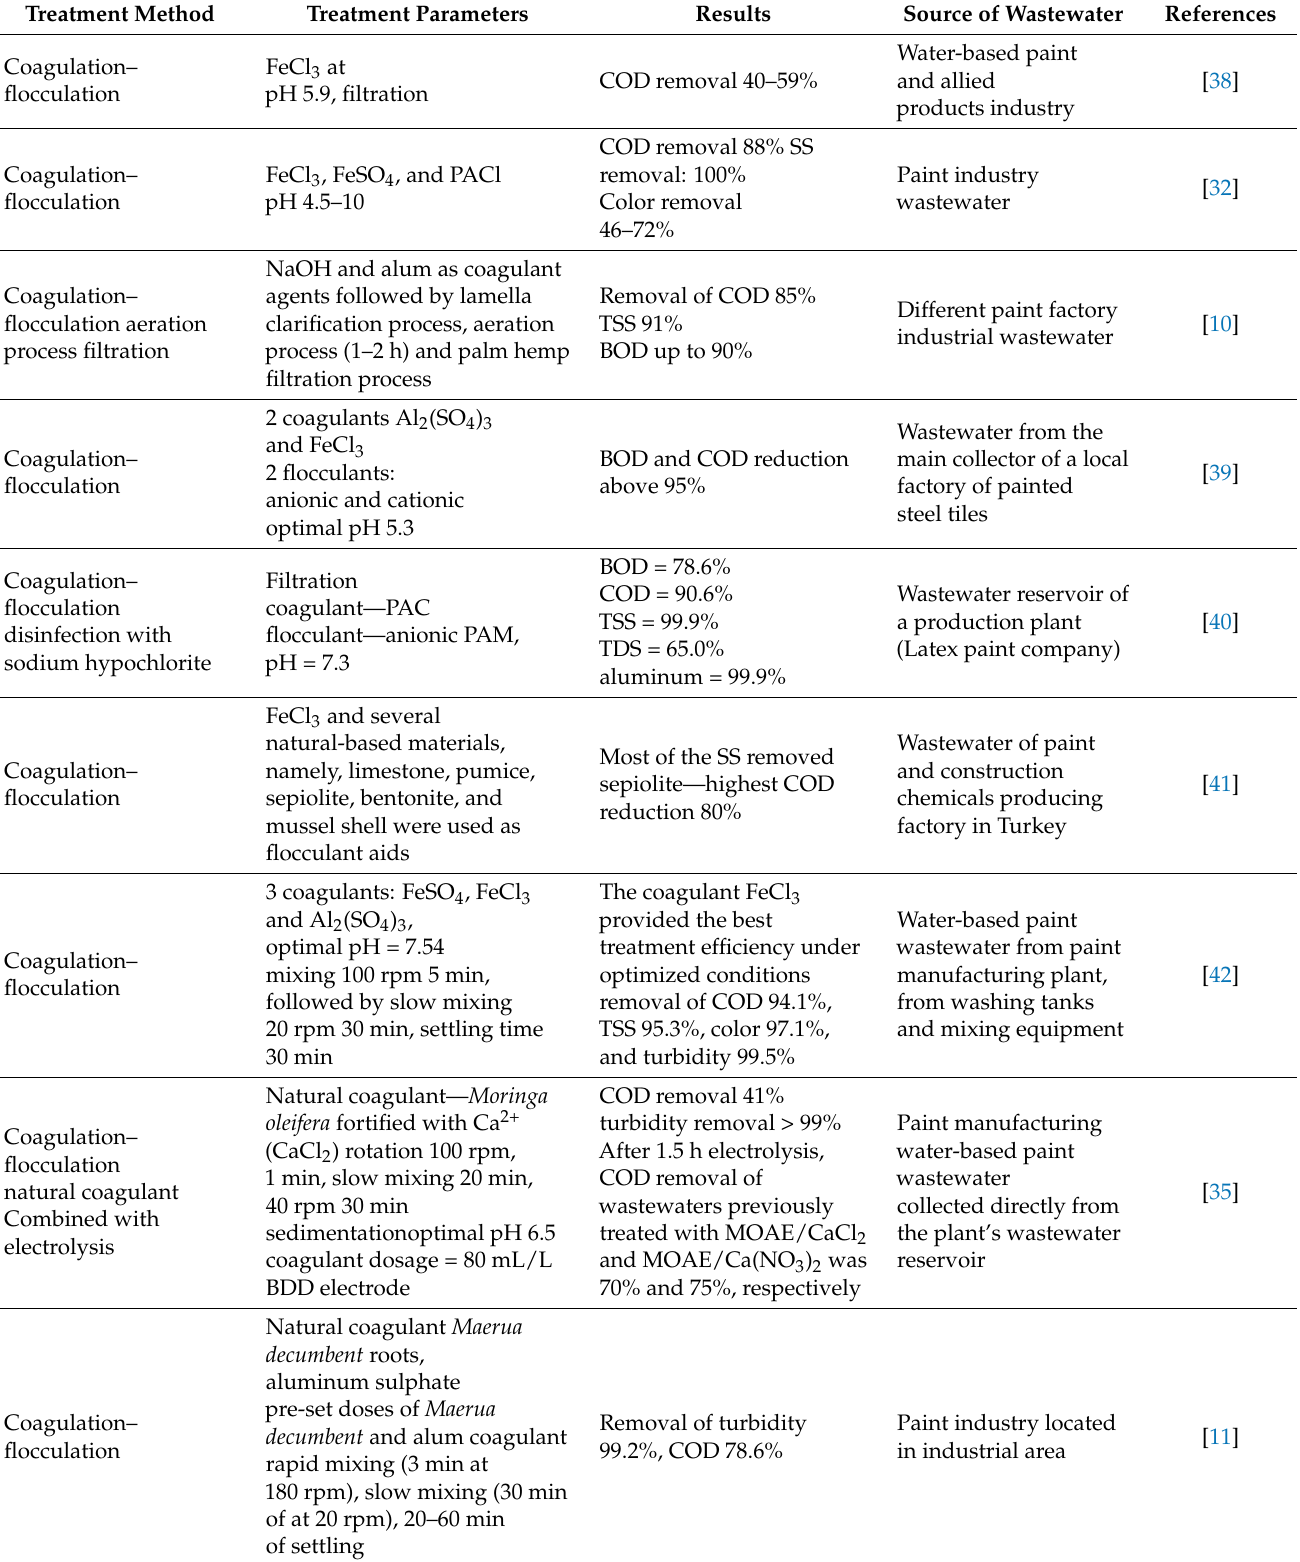
Table 1. Physicochemical treatment methods for paint industry